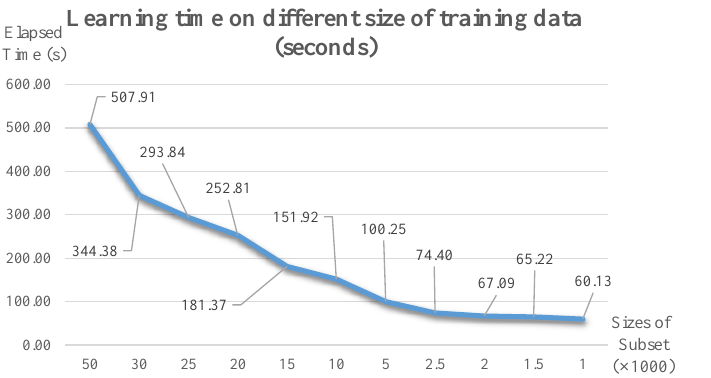
Figure 9. Learning time according to training data size (Unit: s, using NVIDIA GeForce RTX 2080Ti).